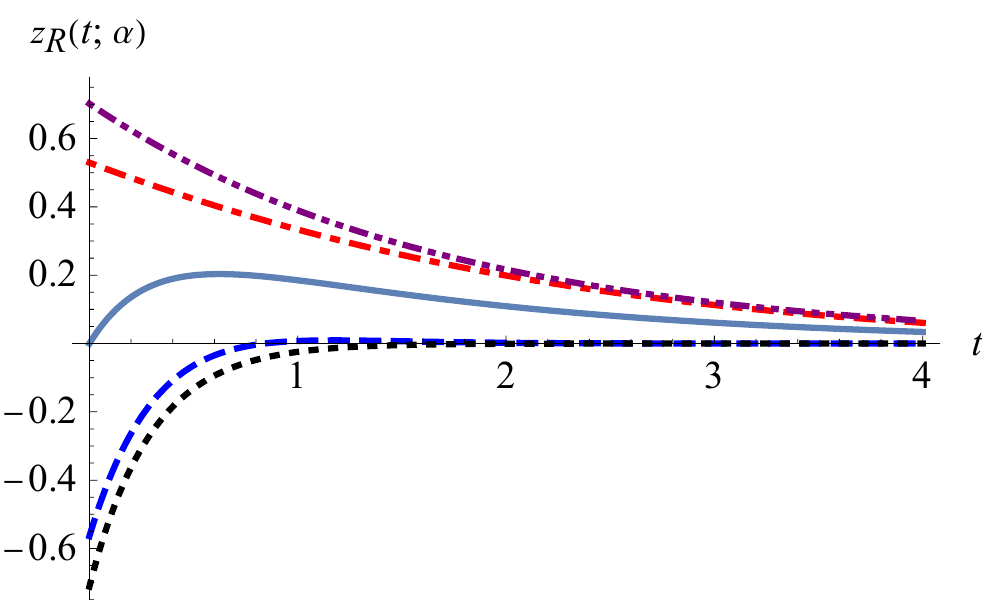
Figure 15. Curves of z ( t ;1 ) (solid line) and residue contribution z R ( t ; α ) for α = 0.9 (dash line), 0.99 (dot line), 1.1 (dot-dash line), 1.01 (dot-dot-dash line), where b = 4 and c = 2 ( b 2 − 4 c > 0).